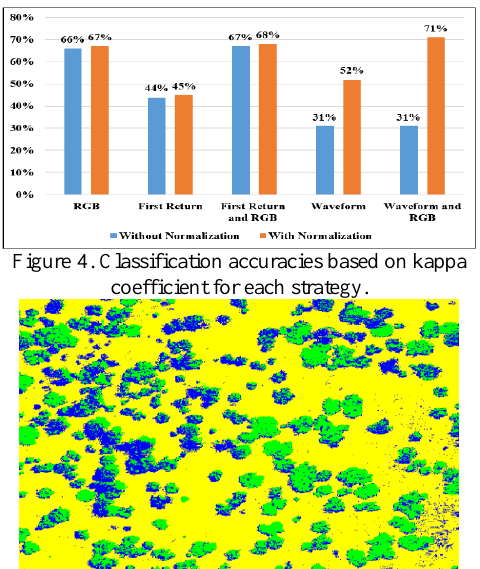
Figure 5. Classification map for the case of using fusion of structural features of full waveform LiDAR and aerial